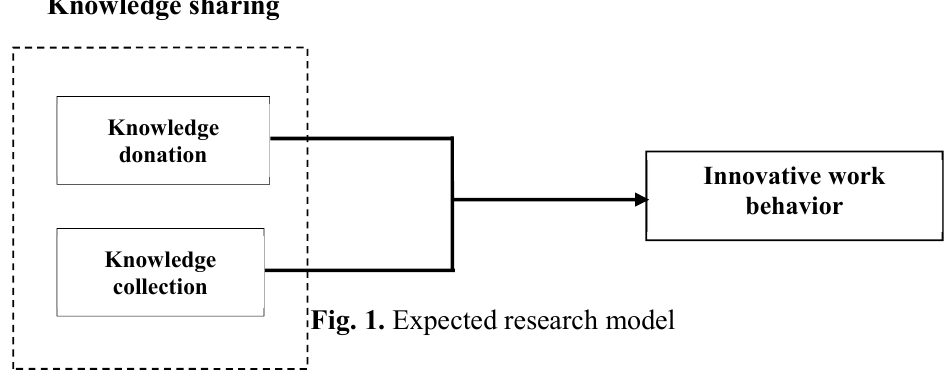
Fig. 1. Expected research